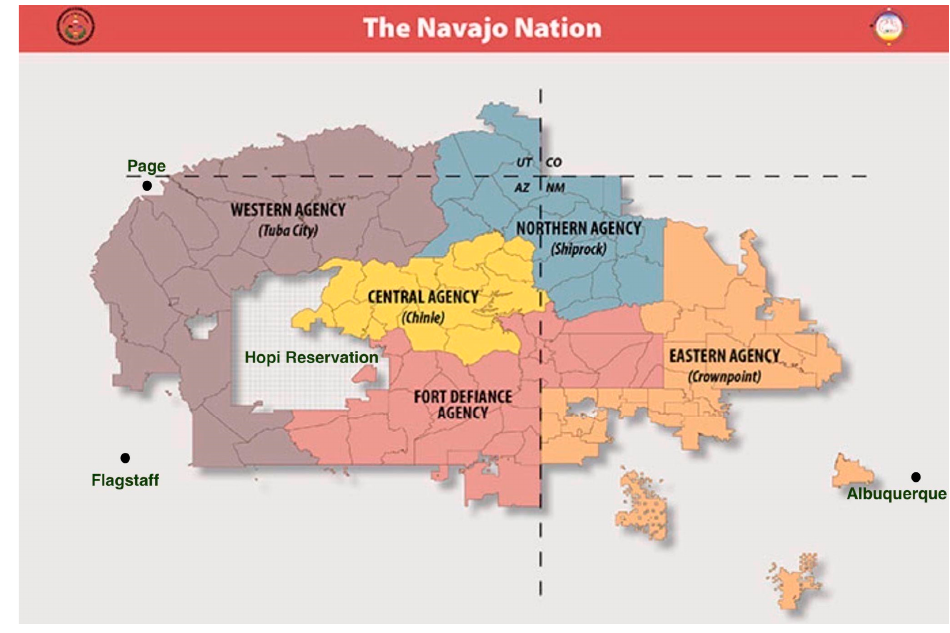
Figure 2. Map of the Navajo Nation with the Agency Councils [23].